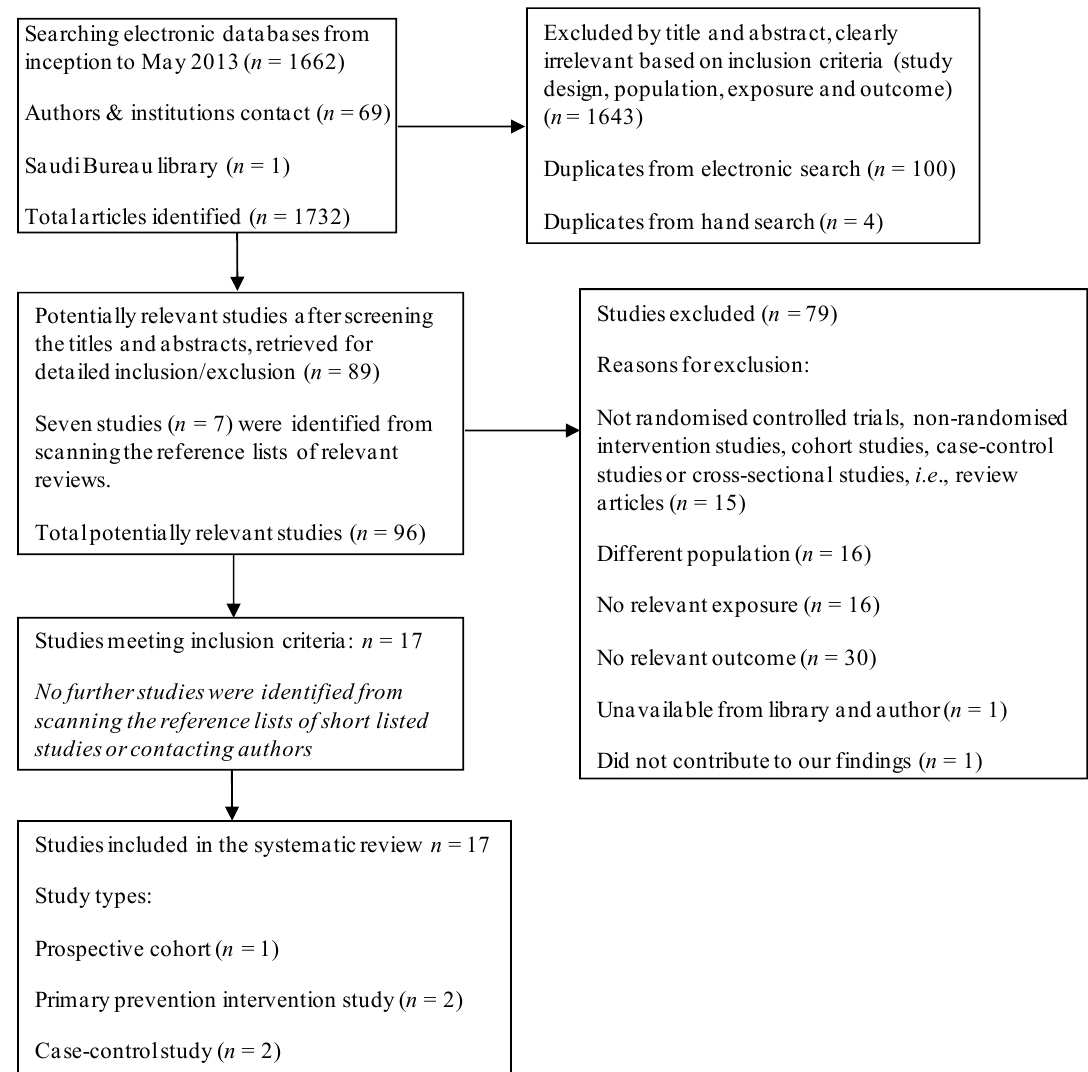
Figure 1. Flow diagram for the selection of